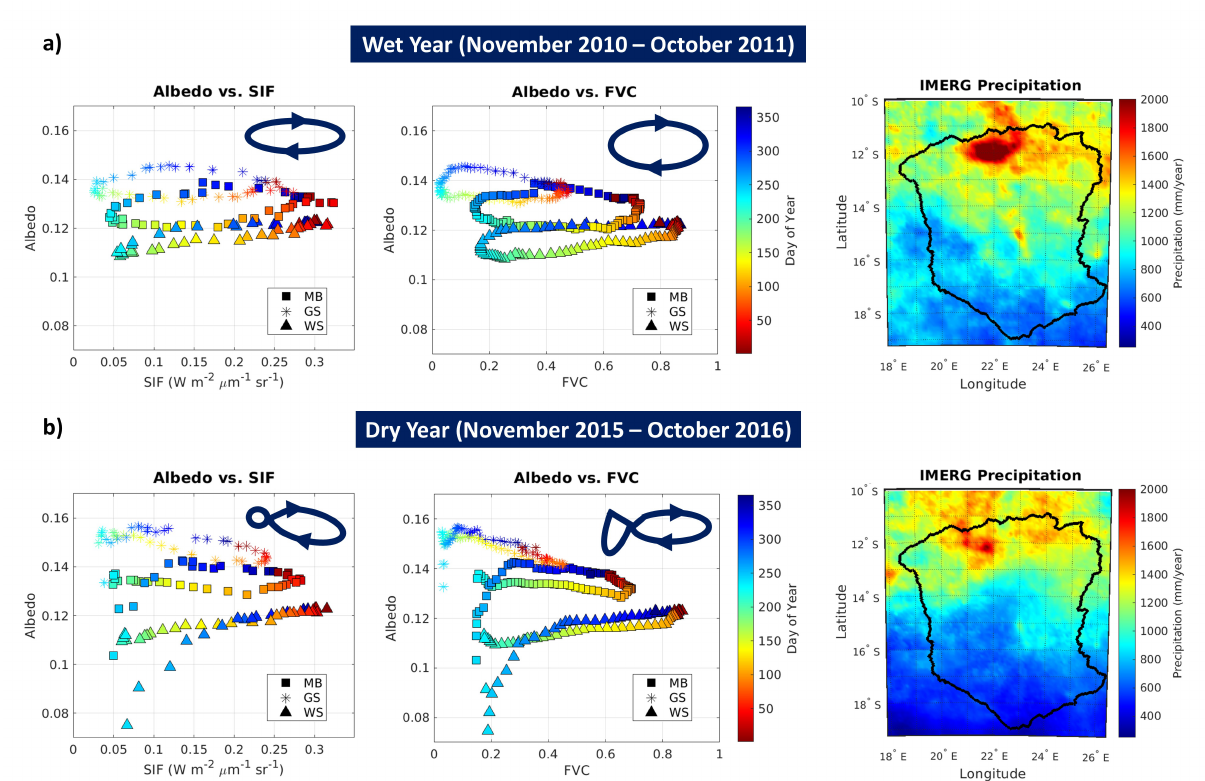
Figure 16. Phase-space analysis of mean albedo, SIF, and FVC values for each land-cover class for ( a ) a wet year (2010–2011) and ( b ) a dry year (2015–2016) across miombo (MB), grass savanna (GS), and woody savanna (WS) land cover types. The accumulated annual precipitation for each year (consecutive rainy and dry seasons from November to October) is shown on the right-hand side for reference. Dark blue elliptical shapes represent the approximate shape of the limit-cycle and arrows indicate the direction of time. The 95% confidence interval values are plotted as horizontal and vertical error bars, with bar lengths representing the distance of the interval endpoints to the mean. Rainy season values in the phase-space diagrams are marked by the dark blue to dark red transition to the right of the graphs and dry season values are marked by the light blue to light green transition to the left of the